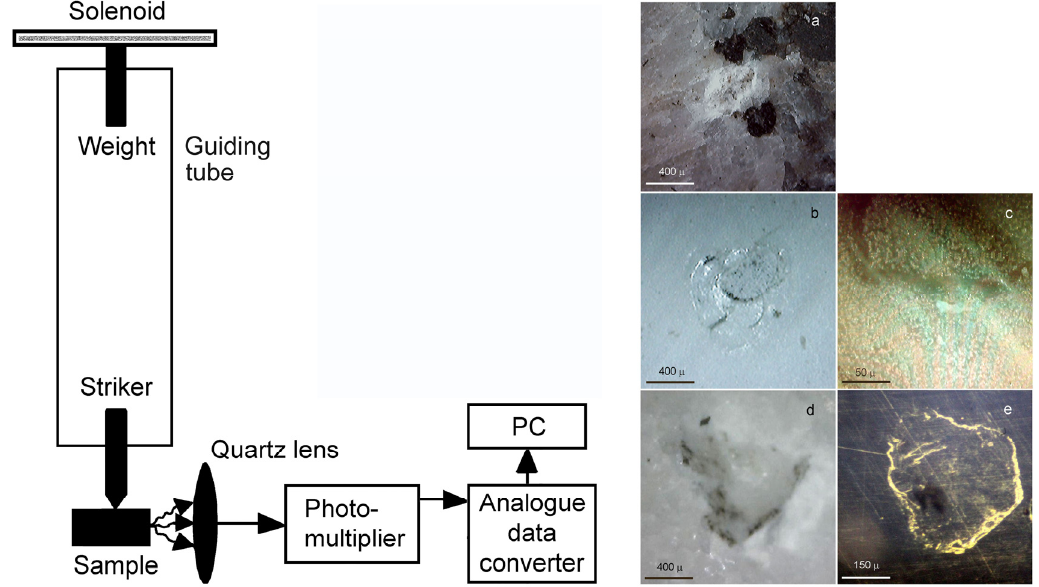
Figure 1: Schematic diagram of the experimental setup and photographs of impact-induced damages in granite (a), silica ceramics (b), silicon carbide (c), marble (d), and organic glass